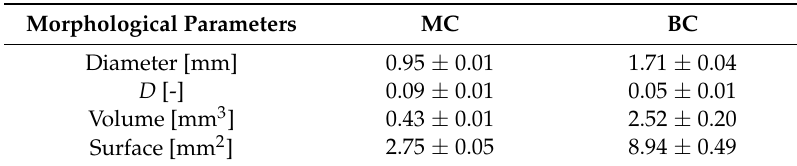
Table 1. Comparison of morphological parameters via image analysis for MC and BC capsules selected for in vitro release tests.